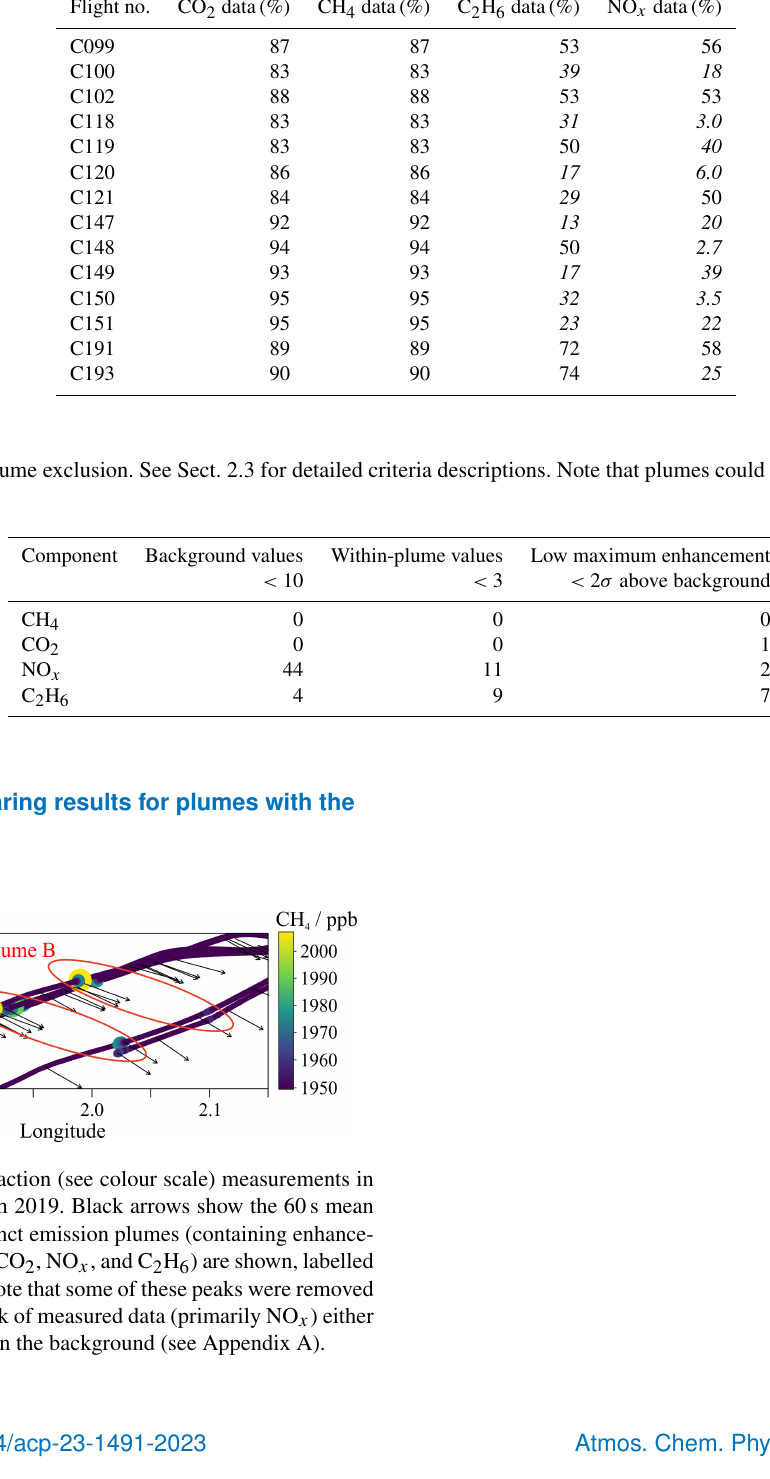
Table A1. Data availability (percentage of total 1Hz data) for CO 2 , CH 4 , C 2 H 6 , and NO x during FAAM AEOG and MOYA flights. Data availability below 50% are given in italics. It should be noted that 100% data availability would not be expected for various reasons. Firstly, data files might contain data outside of when the instruments were operational (e.g. before take-off or after landing) which were removed for analysis, and secondly, due to the presence of instrument calibrations, for which data were flagged and removed. Flight no.